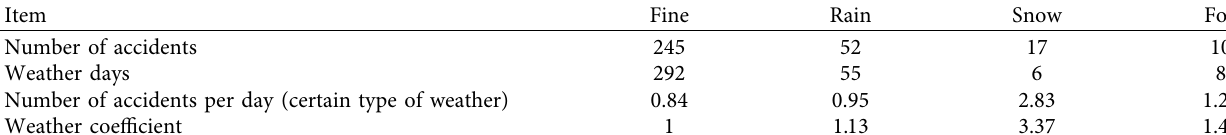
Table 2: Coefficient between weather and accident.